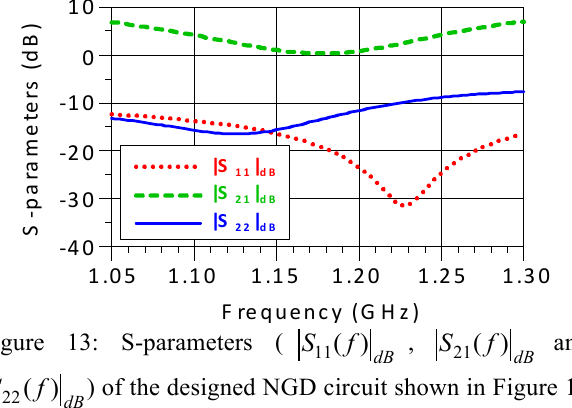
fS )( fS )( , and 11 21 dB dB